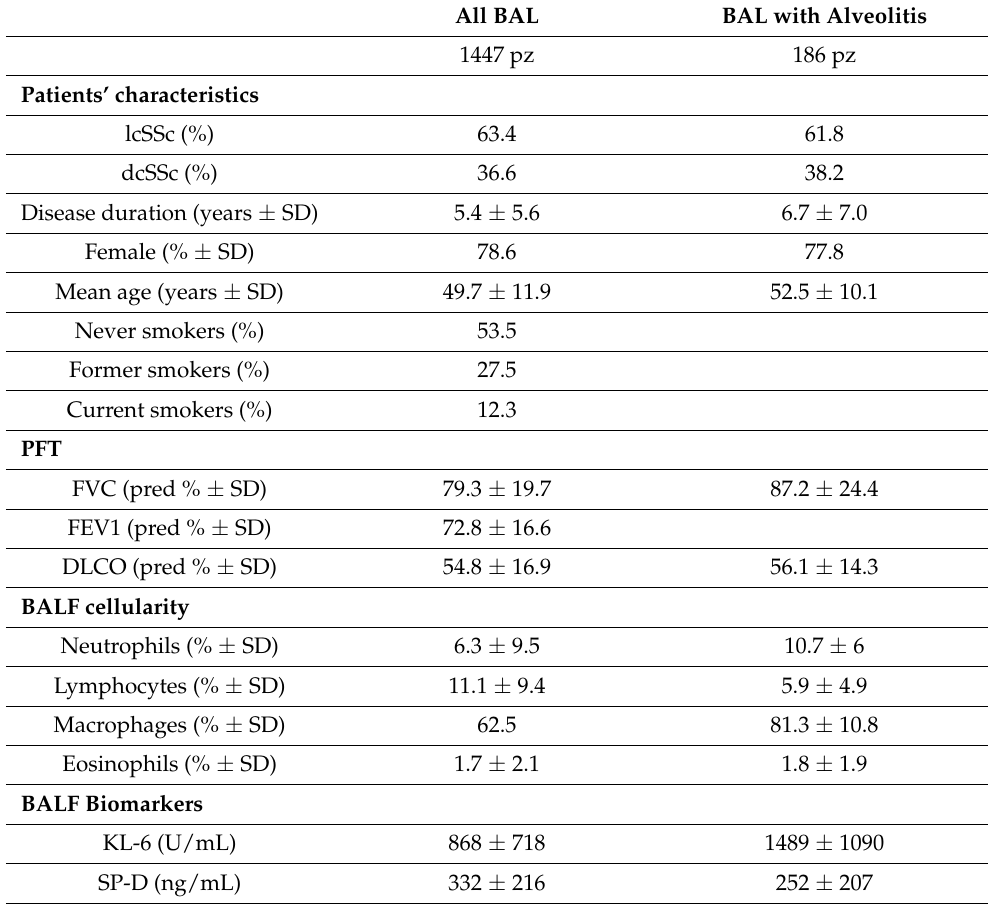
Table 1. Main patients, characteristic in selected studies. All BAL BAL with